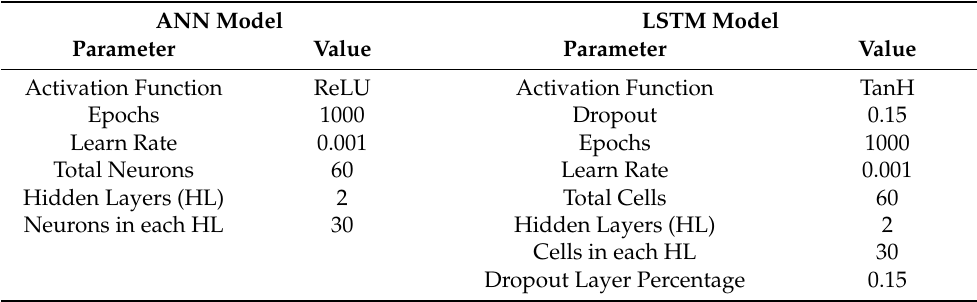
Table 2. Hyperparameters values used in the ANN and LSTM